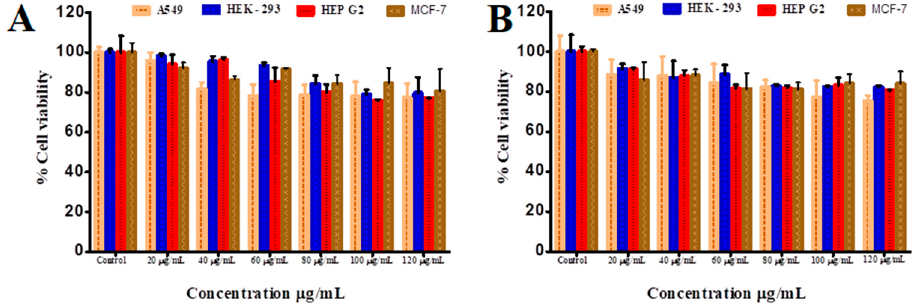
Figure 4. ( A ) Percentage cell viability of StBAclm on different cell lines A-549, HEK-293, Hep-G2, and MCF-7 and ( B ) percentage cell viability of VCM-StBAclm-Qt 1 quatsomes on different cell lines A-549, HEK-293, Hep-G2, and MCF-7.